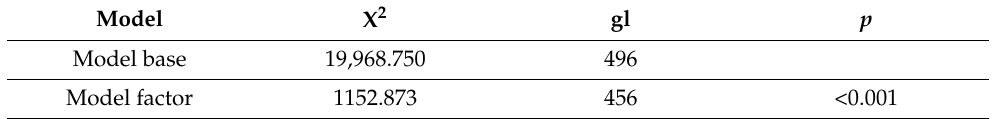
Table 6. Confirmatory factor